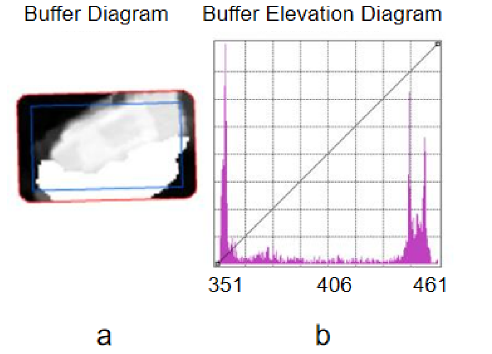
Figure 11. Bottom elevation extraction. ( a ) the buffer of DSM; ( b ) the elevation